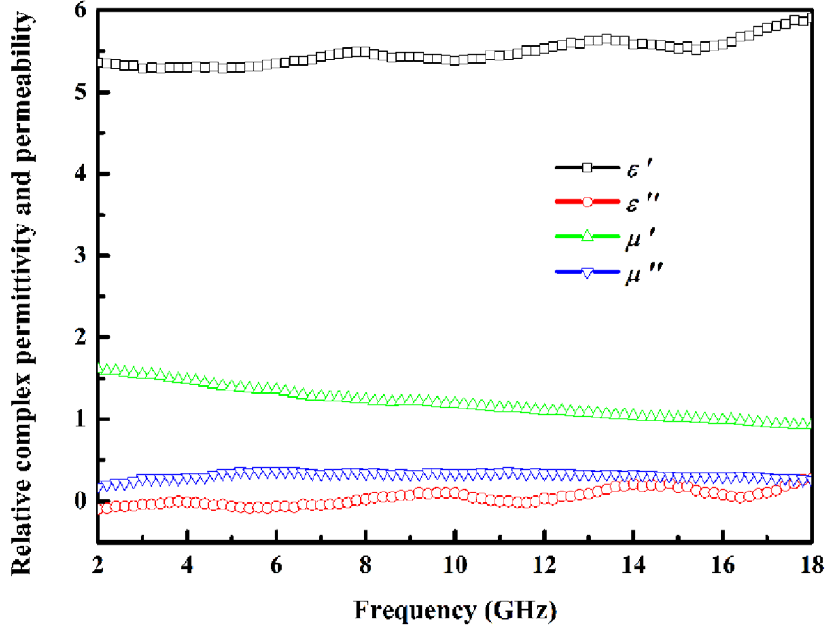
Figure 4. The relative complex permittivity ( e 9 and e 99 ) and permeability ( m 9 and m 99 ) of chain-like Co flower.